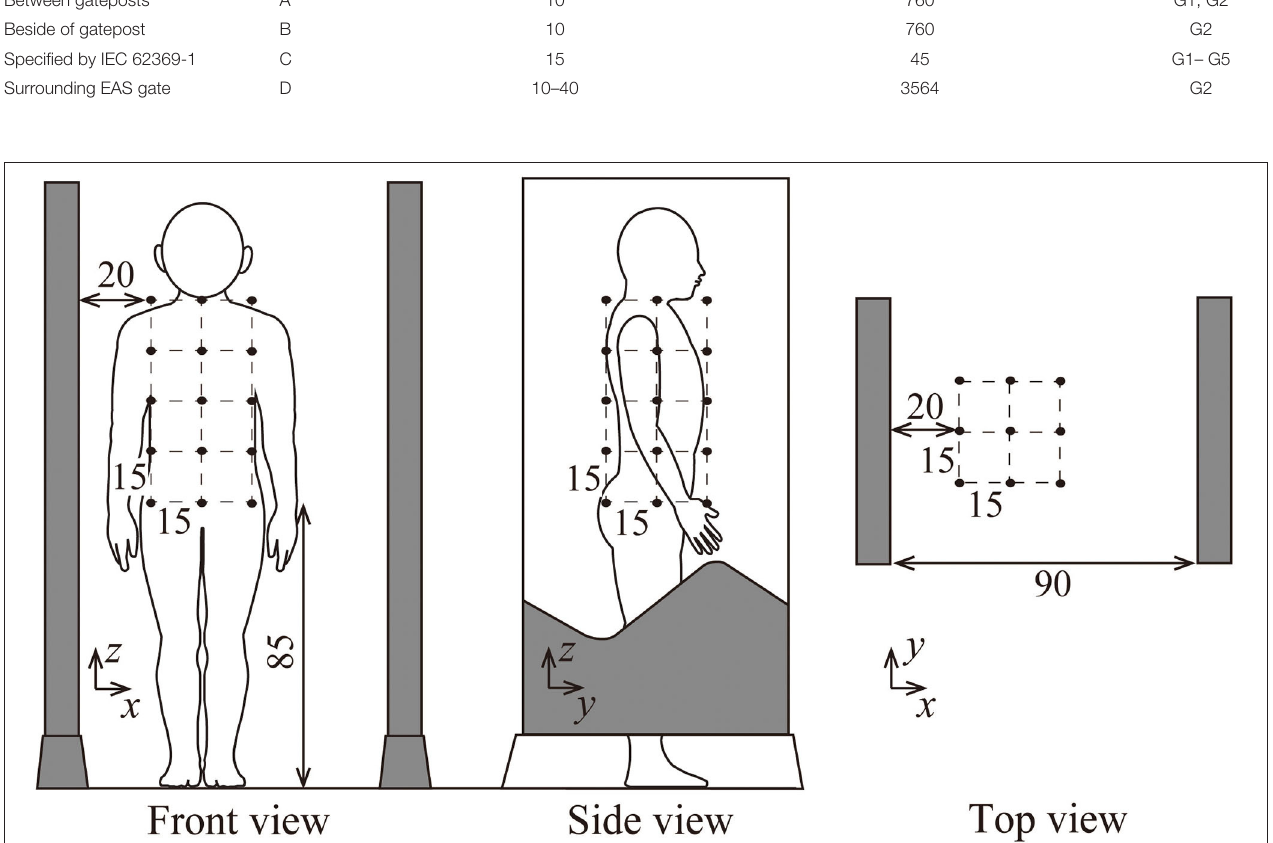
FIGURE 2 | illustration of the grid points specified by IEC 62369-1 for an EAS gate consisting of dual floor standing antenna, a typical EAS gate in libraries.